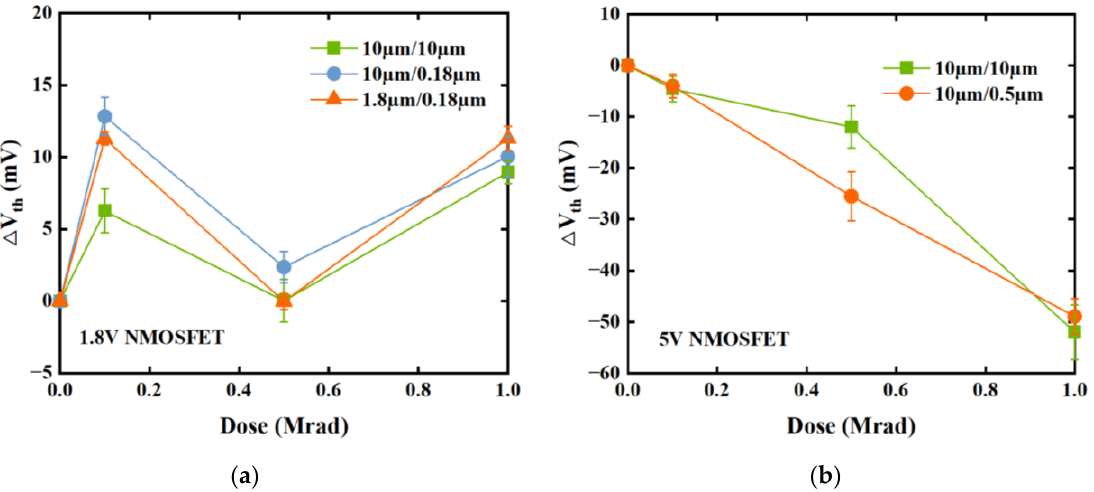
Figure 4. Threshold-voltage shift ∆ V th as a function of irradiation dose for ( a ) 1.8V NMOSFETs with geometries W / L = 10 μm/10 μm, 10 μm/0.18 μm , and 1.8 μm/0.18 μm and ( b ) 5V NMOSFETs with geometries W / L = 10 μm/10 μm and 10 μm/0.5 μm. All devices were irradiated up to 1 Mrad(Si) under the “on” bias condition.